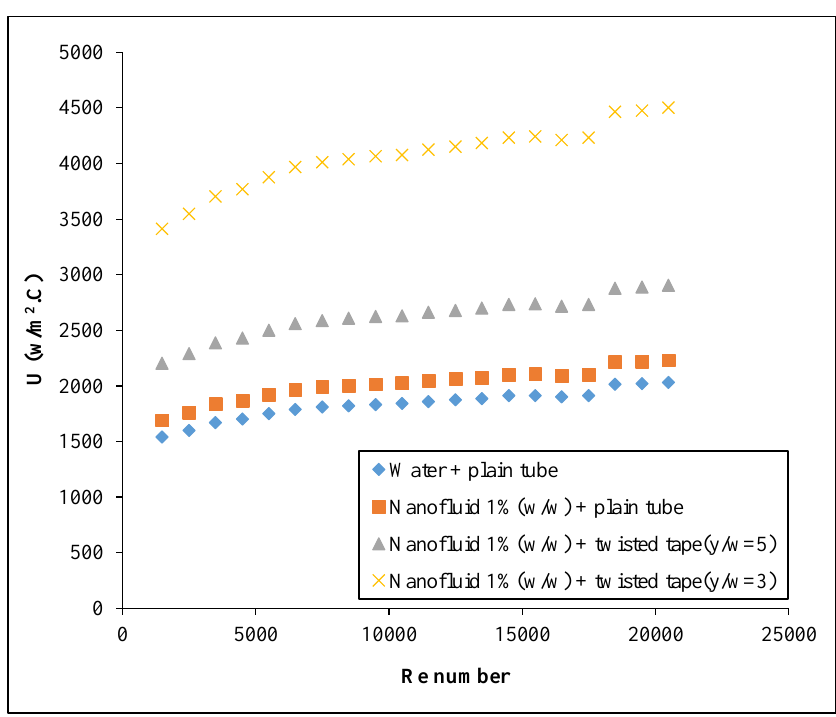
Figure 2. Variation of mean heat flow rate with Reynolds number.